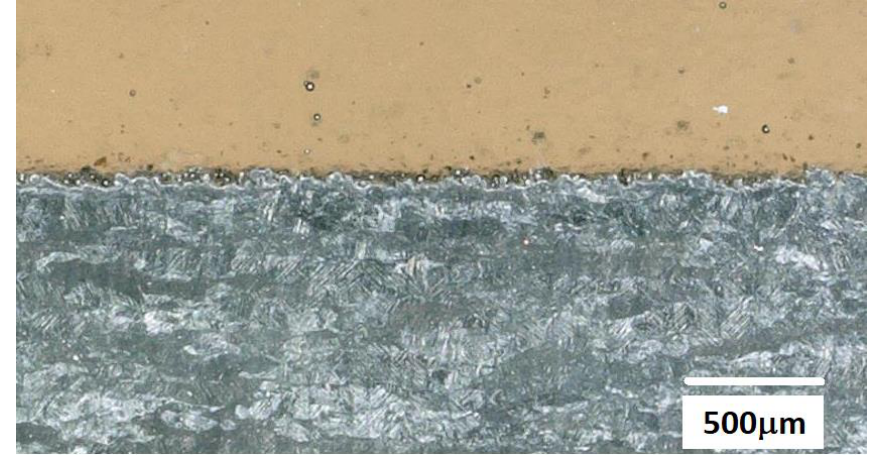
Figure 17. Partially melted, poorly adherent particles at the edge of a sample cross-section.